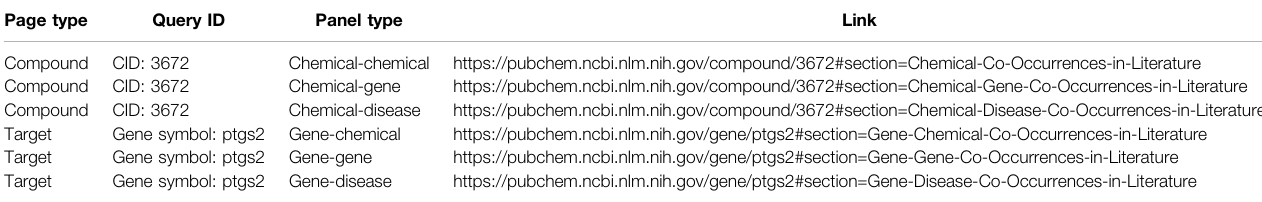
TABLE 1 | Types of literature co-occurrence panels implemented in PubChem with